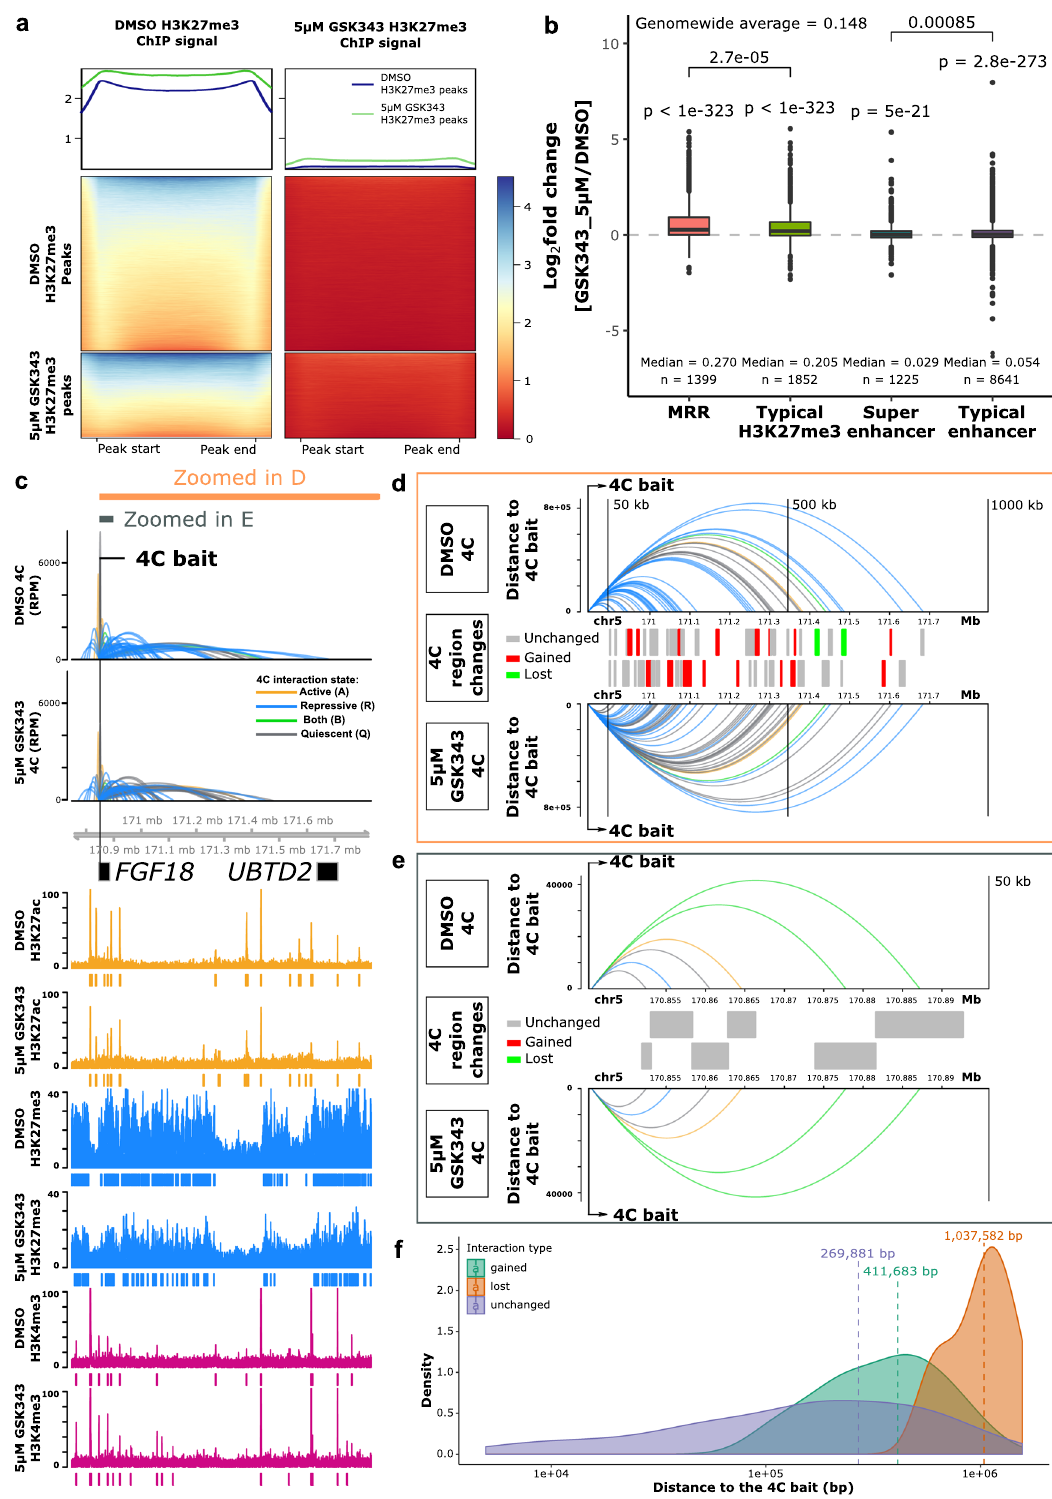
similar manner except that a stitching window of 12.5kb was used and H3K27ac ChIP-seq signal was used in the ranking process. Cell culture . GM12878 normal lymphoblastoid cell line and Chronic Myelogenous Leukemia cell line K562 were cultured in RPMI-1640 supplemented with 10% Fetal Bovine Serum (FBS) and 1% penicillin-streptomycin. HAP1 cell line is a haploid human cell line that was derived from KBM7 cells 66 . HAP1 wild-type cells (pur- chased from Horizon) were cultured in IMDM supplemented with 10% FBS